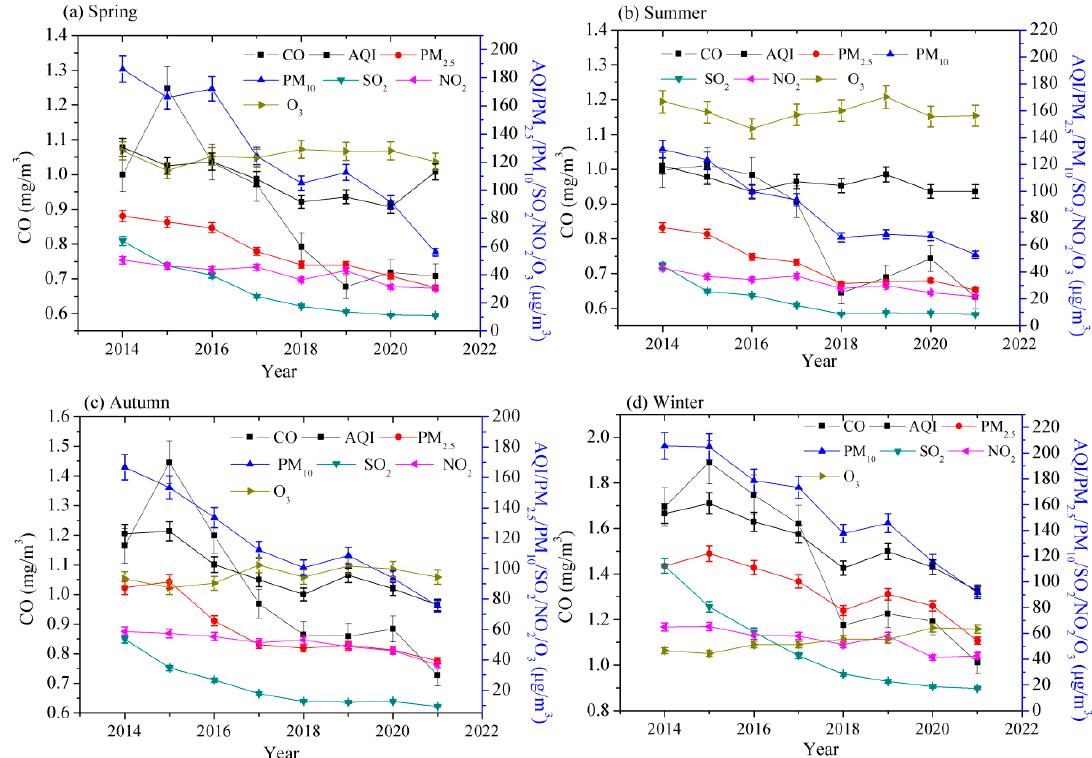
Figure 2. Seasonal variations in air quality in Jinan City during 2014–2021. ( a ) the changes of air quality in spring; ( b ) the changes of air quality in summer; ( c ) the changes of air quality in autumn; ( d ) the changes of air quality in winter.